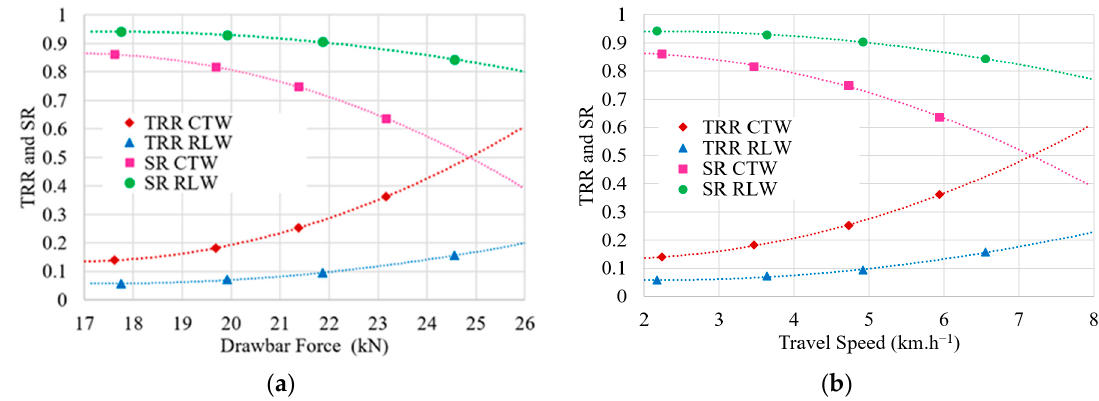
Figure 6. Comparison of travel reduction ratio and a speed ratio of both traction wheels against ( a ) drawbar force and ( b ) travel speed.